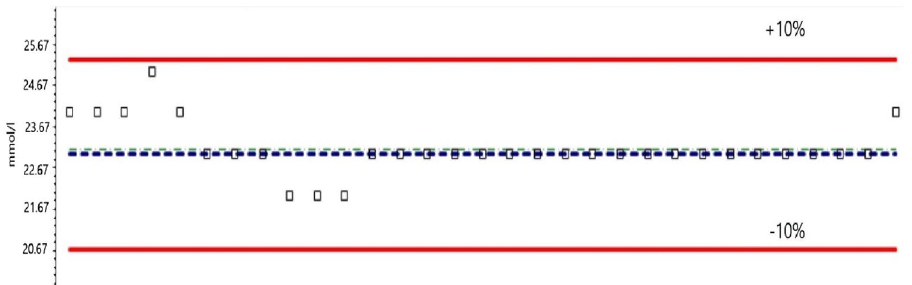
Fig. 5 The course of the low sweat control in the qual- ity interval, with the mean 23 mmol/l. In this analysis a total of 30 measurements were